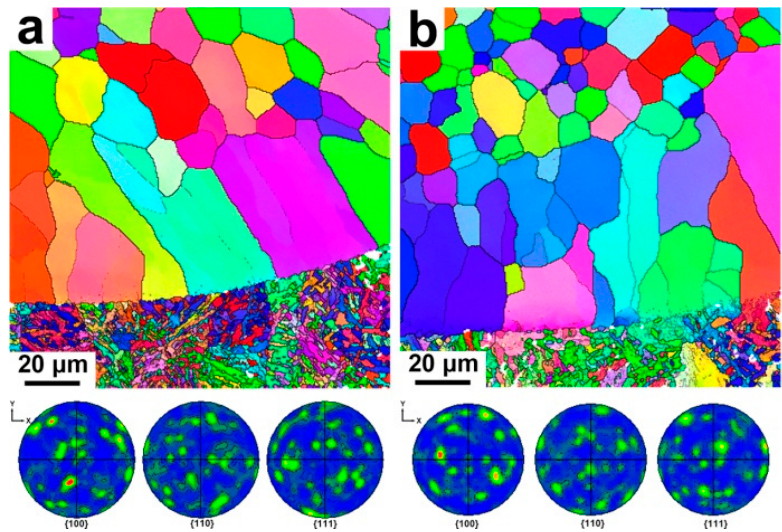
Figure 5. Inverse pole figure-X direction (IPF-X) electron backscatter diffraction (EBSD) maps of the bottom regions of Fe–Si–Al coating ( a ) specimen 1 and ( b ) specimen 4 with their corresponding {100}, {110}, and {111} pole figures.